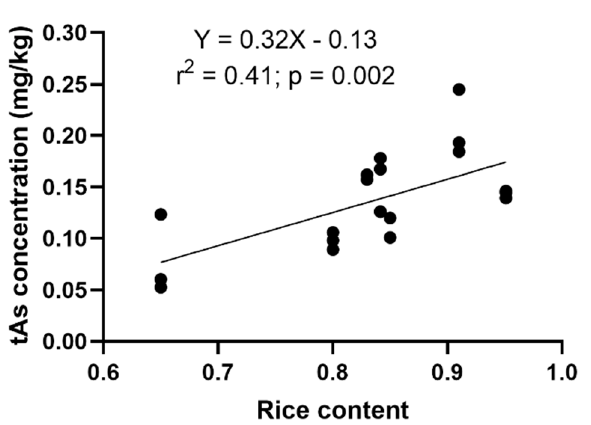
Figure 1. Relationship between total arsenic (tAs) concentration and the proportion of rice in infant rice crackers.